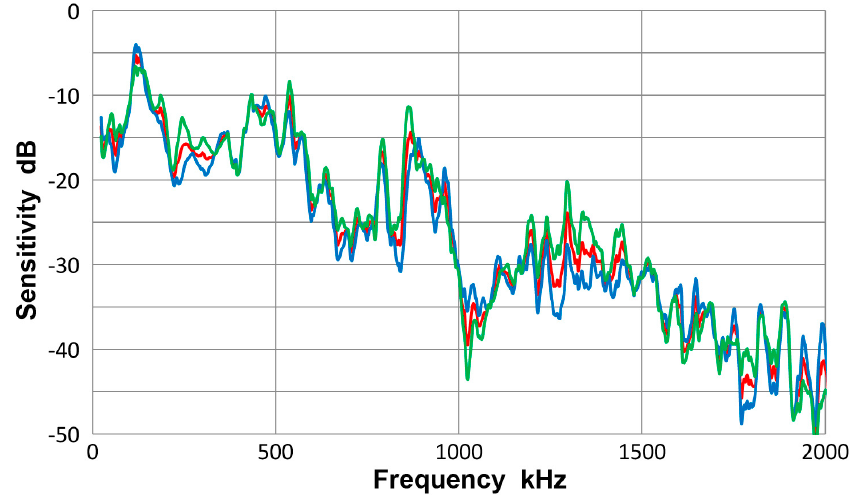
Figure 10. Receiving sensitivity of PAC Pico sensor. Red -averaged guided wave sensitivity, blue -Lamb waves for 12.7 and 6.4 mm plates, green -bar waves for 12.7 and 6.4 mm bars.